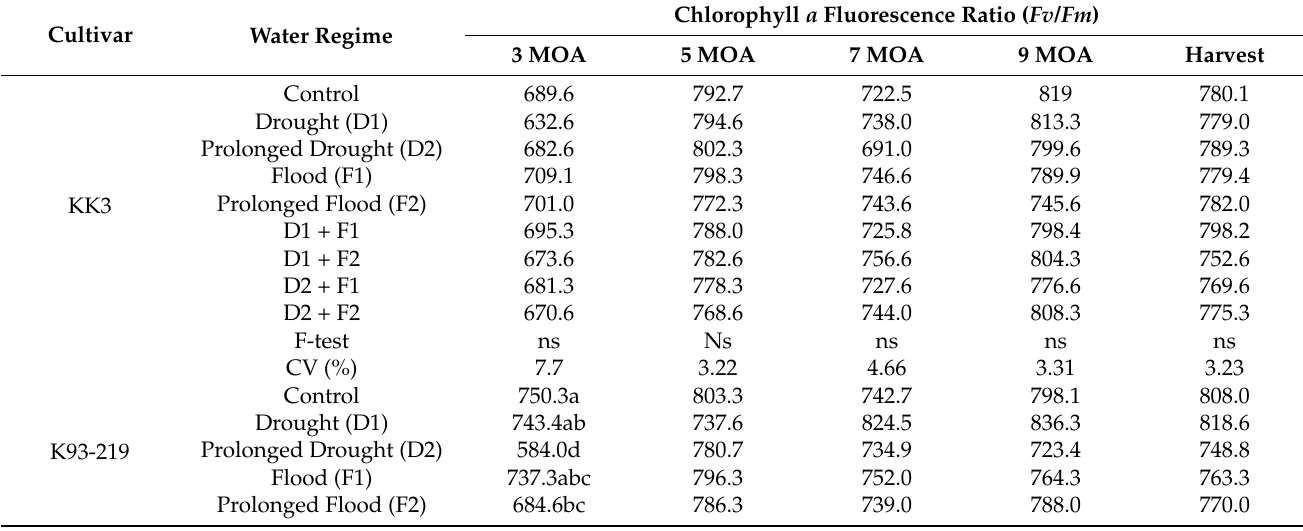
Table 3. Chlorophyll a fluorescence ratio ( Fv/Fm ) of two sugarcane cultivars at 3, 5, 7, 9 months of age, and harvest as affected by drought, flood, and combined treatment, Experiment 1.